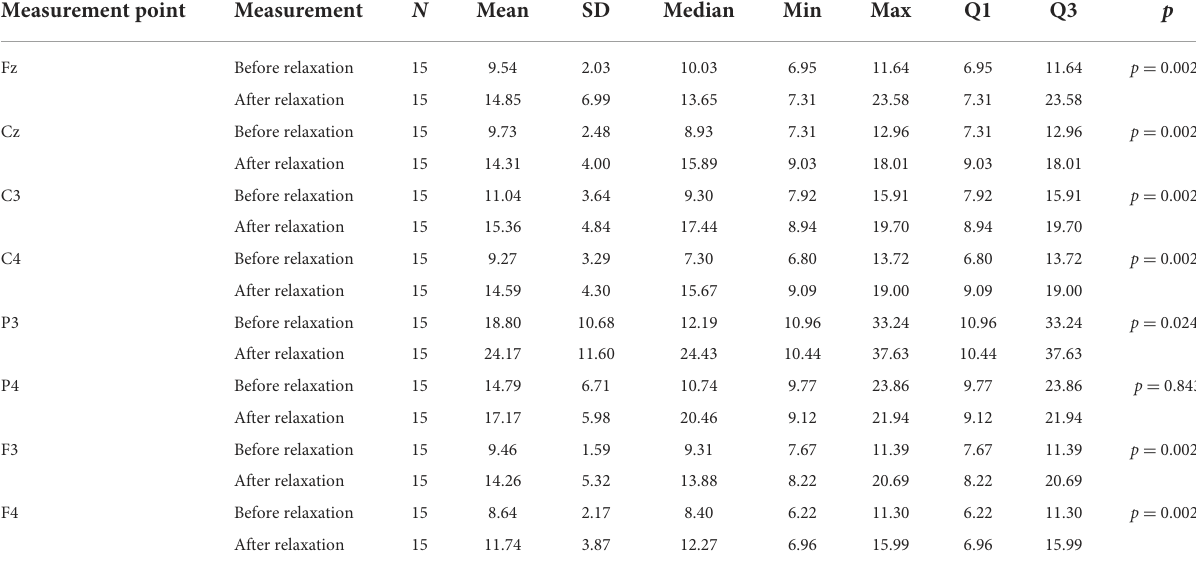
TABLE 1 Comparison of Alpha wave amplitudes before the SKY course (first day) and after the whole SKY course (third day) with eyes open. Measurement point